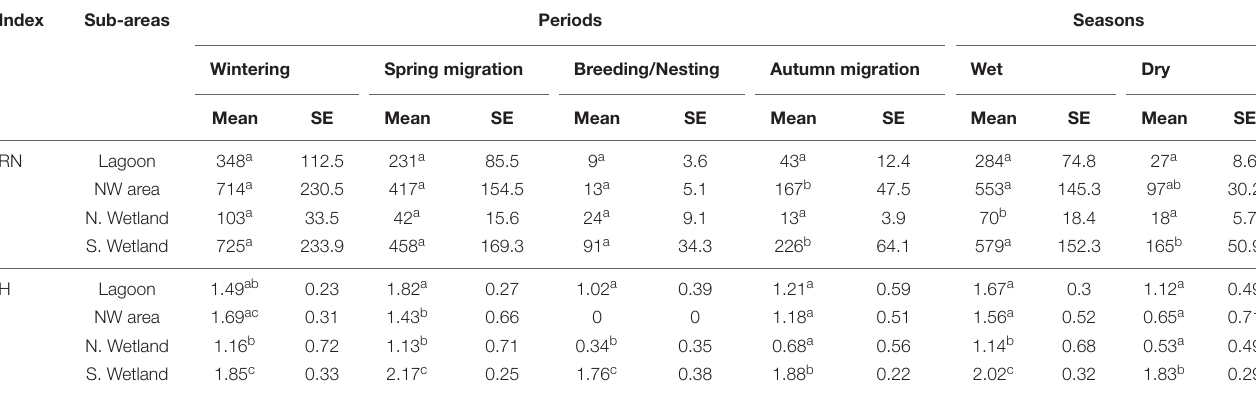
TABLE 5 | Estimated marginal means (Mean) and standard errors (SE) for waterbirds’ relative abundance (RN), and corresponding mean values of the Shannon-Weaver index in the different sub-areas per season and per period.